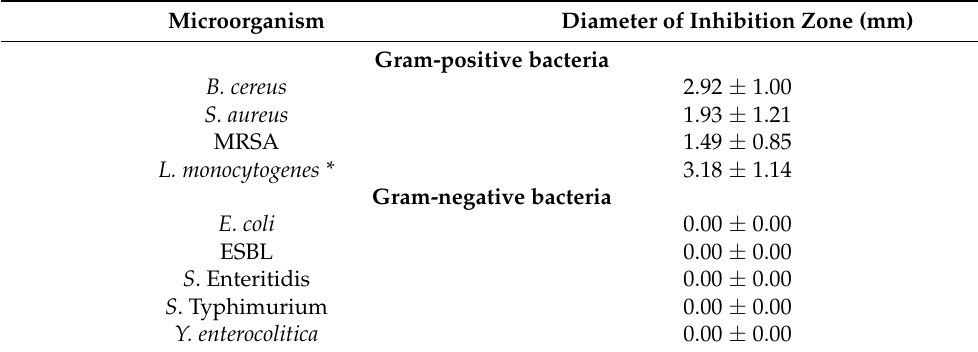
Table 3. Antimicrobial activity of the JKRB biofoil against Gram-positive and Gram-negative bacteria. Values are expressed as mean ± SD ( n =